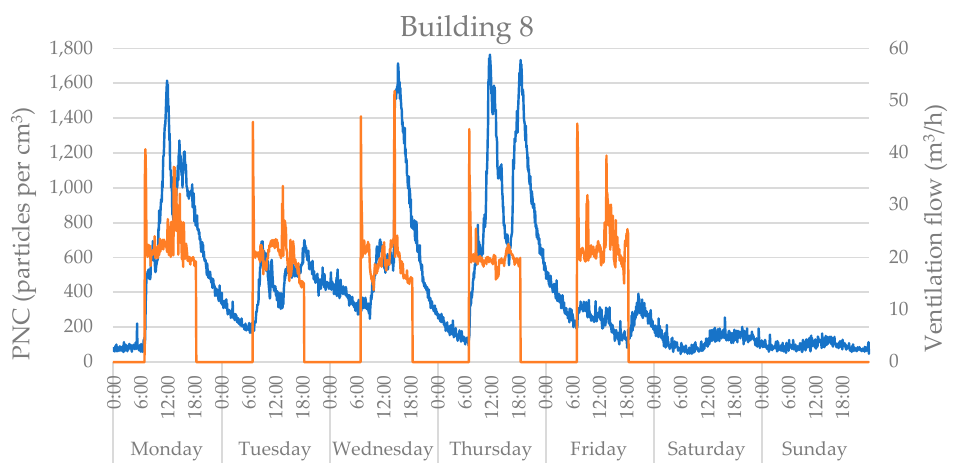
Figure 8. The NP number concentration (blue line) and the ventilation flow (orange line) in Building 8 during the heating season. The NP concentrations and the ventilation flow were measured in five-minute intervals.